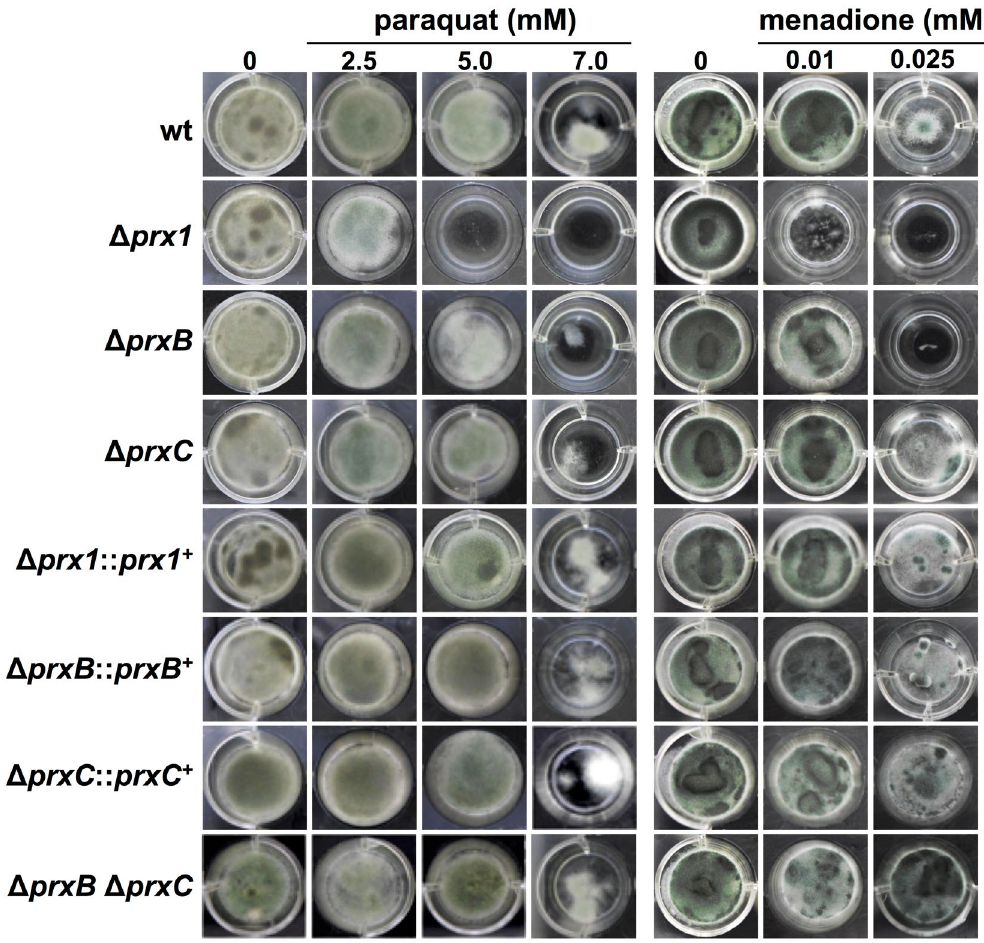
Figure 4. Prx null mutants are sensitive to oxidative-damaging agents. 1 × 10 4 conidia of wild-type, mutant and complemented strains were inoculated in 1 ml of MM (24 well plates) supplemented or not with varying concentration of paraquat and menadione. Plates were incubated at 37 °C for 72 h and then photographed. Experiments were repeated three times and a representative result is